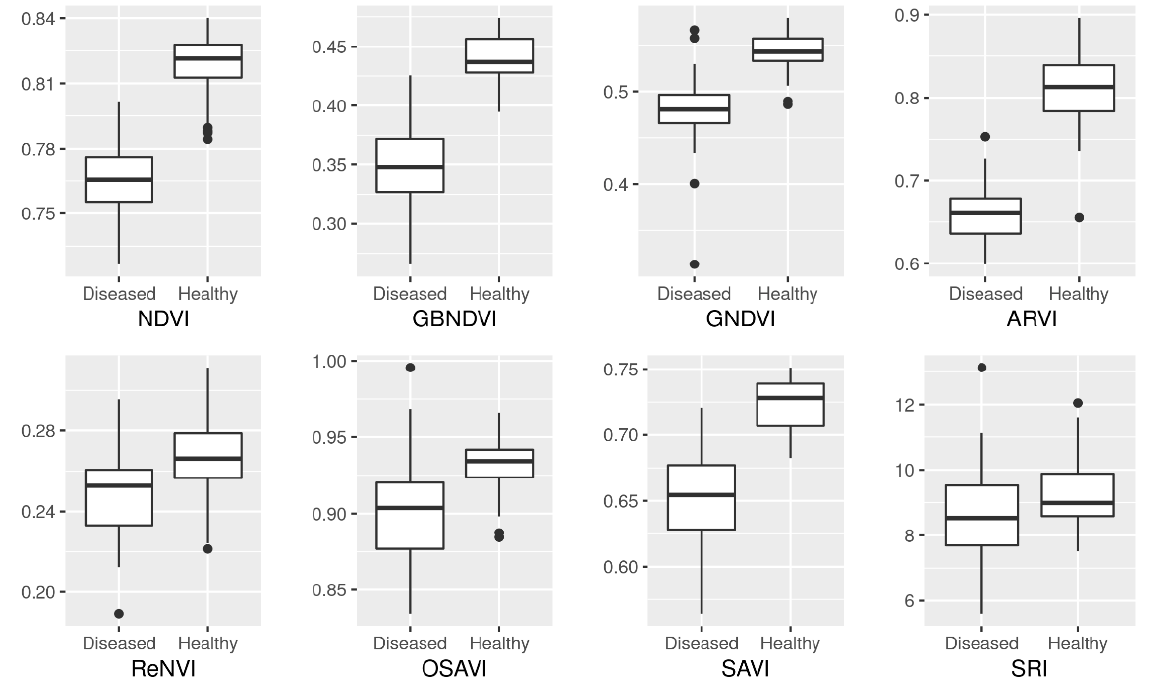
Table 3. The analysis in the pixel based spatial data was based on the characteristics of the reflectance value for each pixel image that is evaluated during the process.